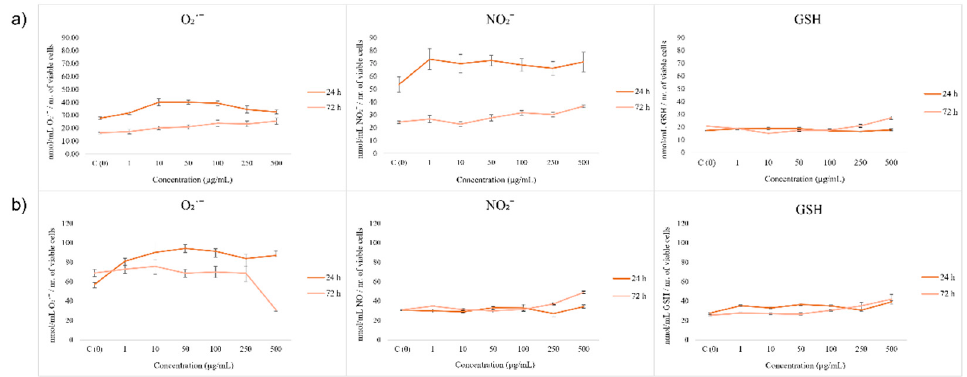
Figure 2. Effects of LSEA on redox status parameters in HCT ‐ 116 ( a ) and HeLa ( b ) cells, 24 and 72 h after treatment.